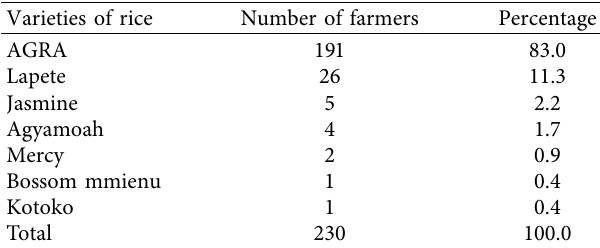
Table 2: Percent distribution of varieties of rice cultivated by farmers in the three rice growing districts. Varieties of